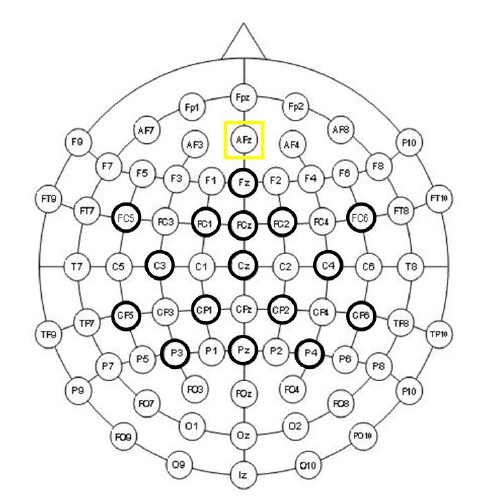
Figure 1. Placement of the electrodes according to the International 10/10 System.